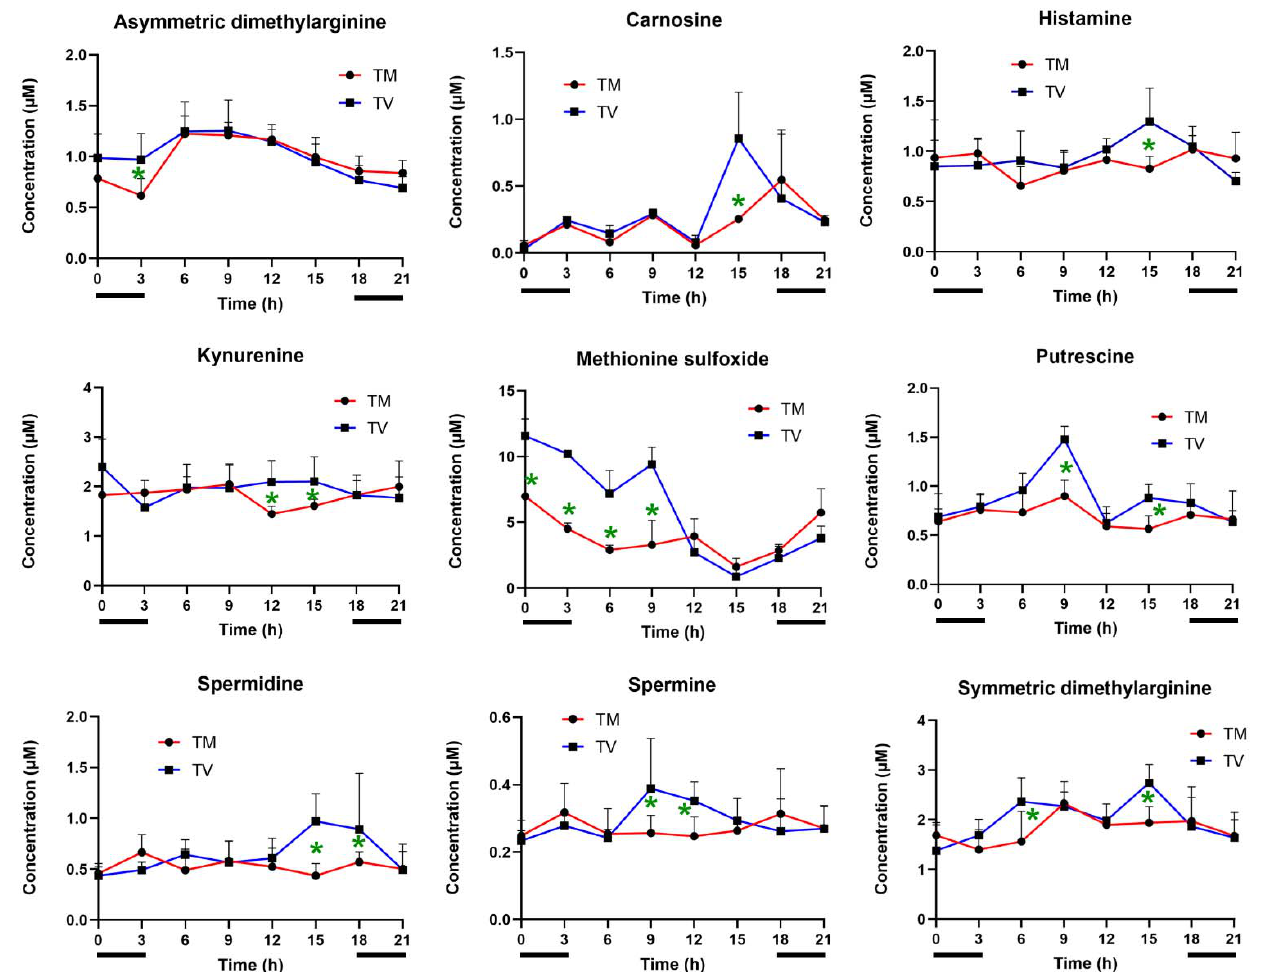
Figure 5. Concentration of biogenic amines in BC-bearing mice. Plasma biogenic amines were meas- ured at eight time points after treatment with melatonin or vehicle only. Light phases included 06:00, 09:00, 12:00, and 15:00. Dark phases included 18:00, 21:00, 00:00, and 03:00 (horizontal black bars). Data represent the mean ± SD of the concentrations (µM) among the experimental groups (TM: tu- mor treated with melatonin; TV: tumor treated with vehicle). Student’s t -test. * p < 0.05.